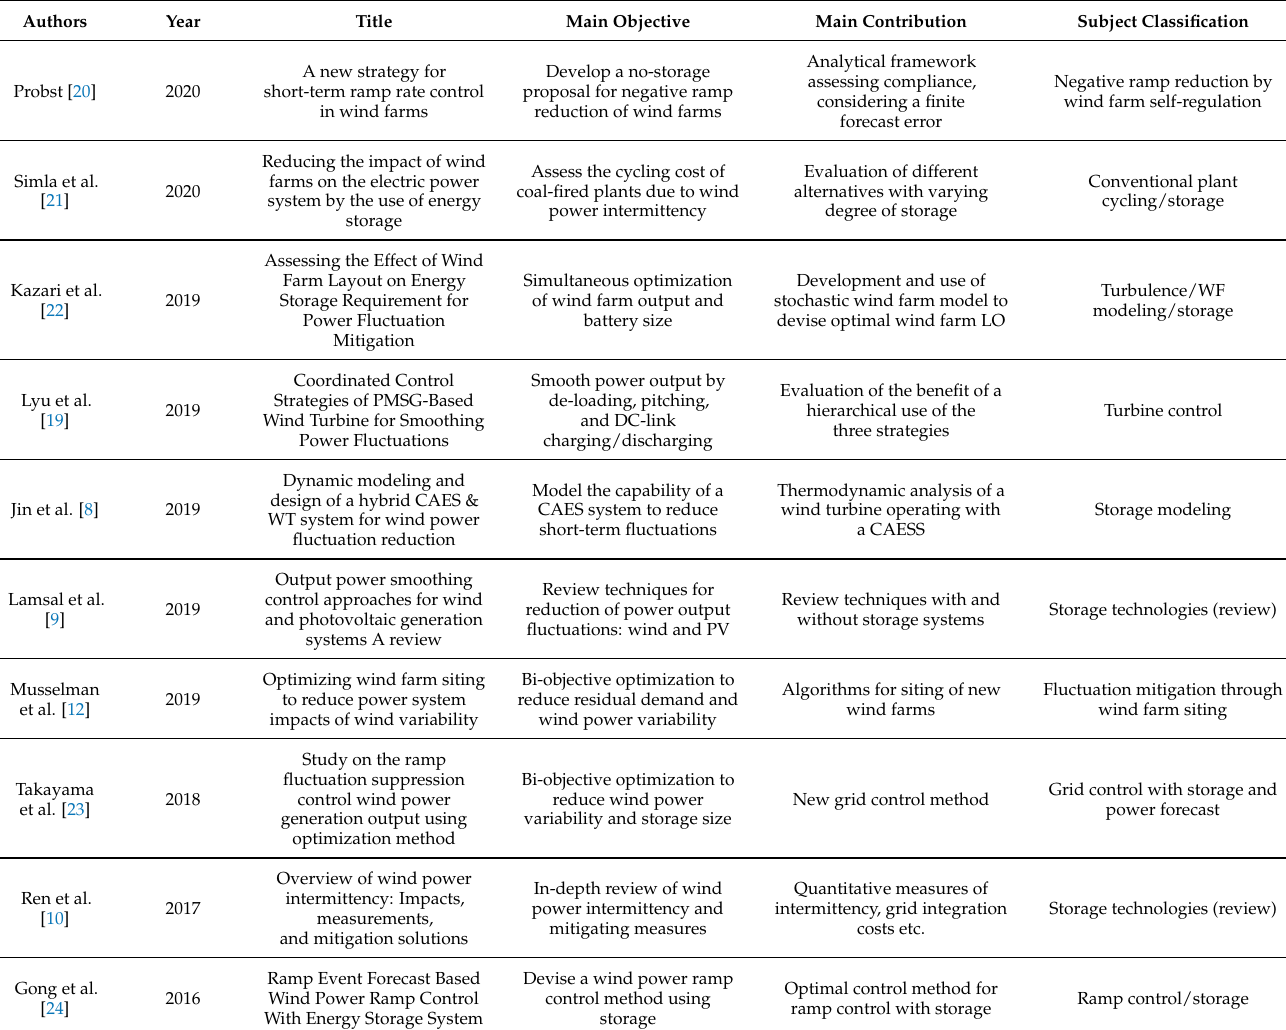
Table 1. Overview of the recent literature on the study and mitigation of wind power